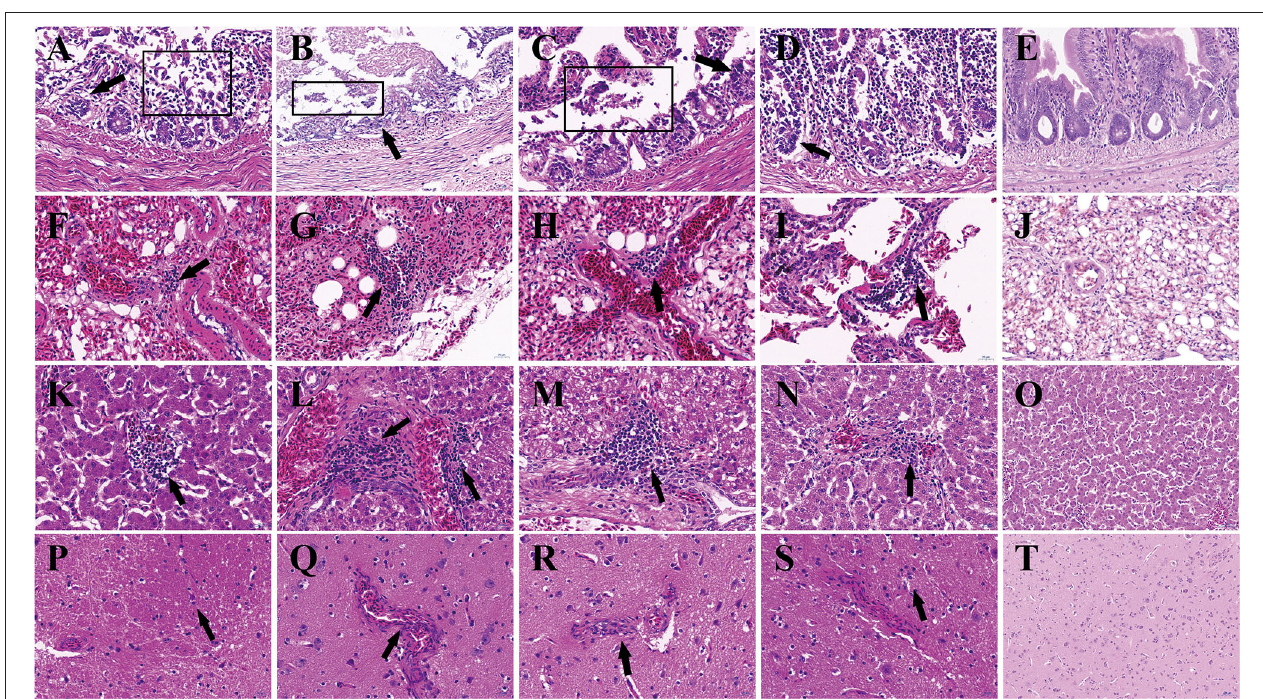
FIGURE 3 | Histopathologic lesions in pigeons of groups. The groups and tissues were marked in the figure. Black arrow indicated the severe histopathologic. (A,F,K,P) Histopathologic lesions in group IC. (B,G,L,Q) Histopathologic lesions in Group IN. (C,H,M,R) Histopathologic lesions in group IO. (D,I,N,S) Histopathologic lesions in group CO. (E,J,O,T) Histopathologic lesions in group N. (A–E) Small intestine. (F–J) Lung. (K–O) Liver. (P–T) Cerebrum. The pictures were magnified × 40.